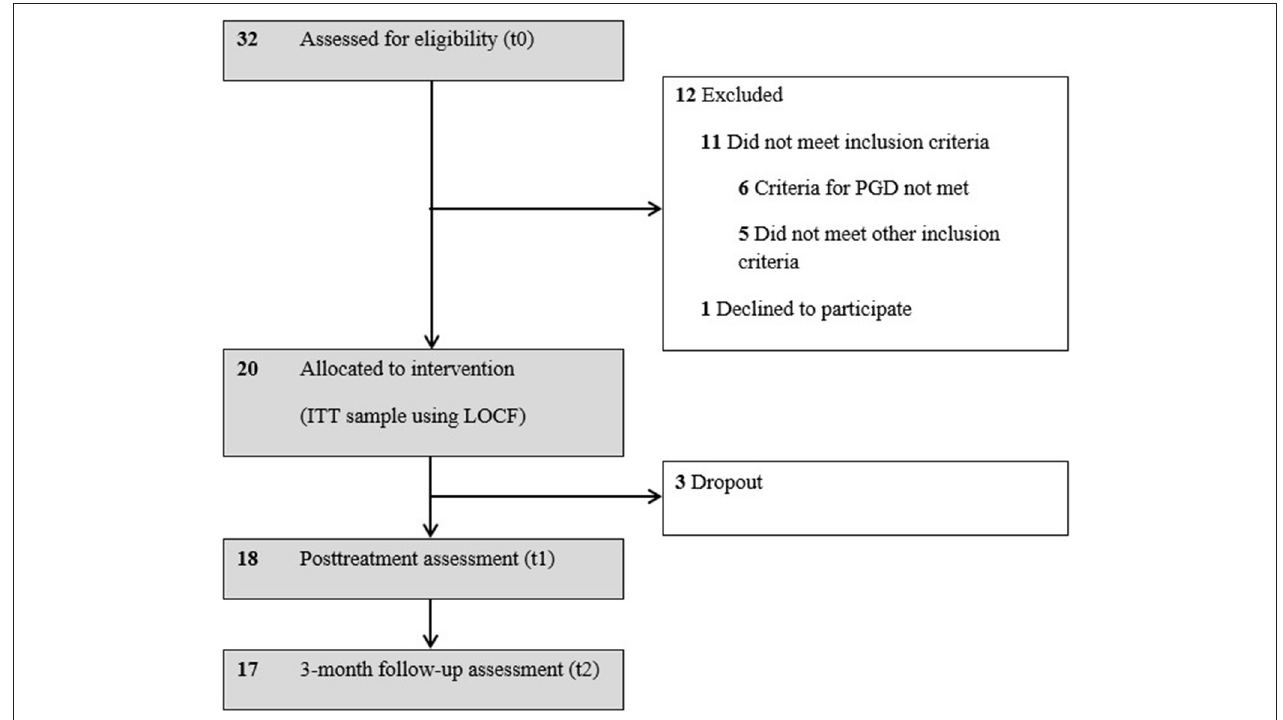
FIGURE 1 | Flow diagram of study participants. ITT, intent-to-treat; LOCF, last observation carried forward; PGD, prolonged grief disorder.